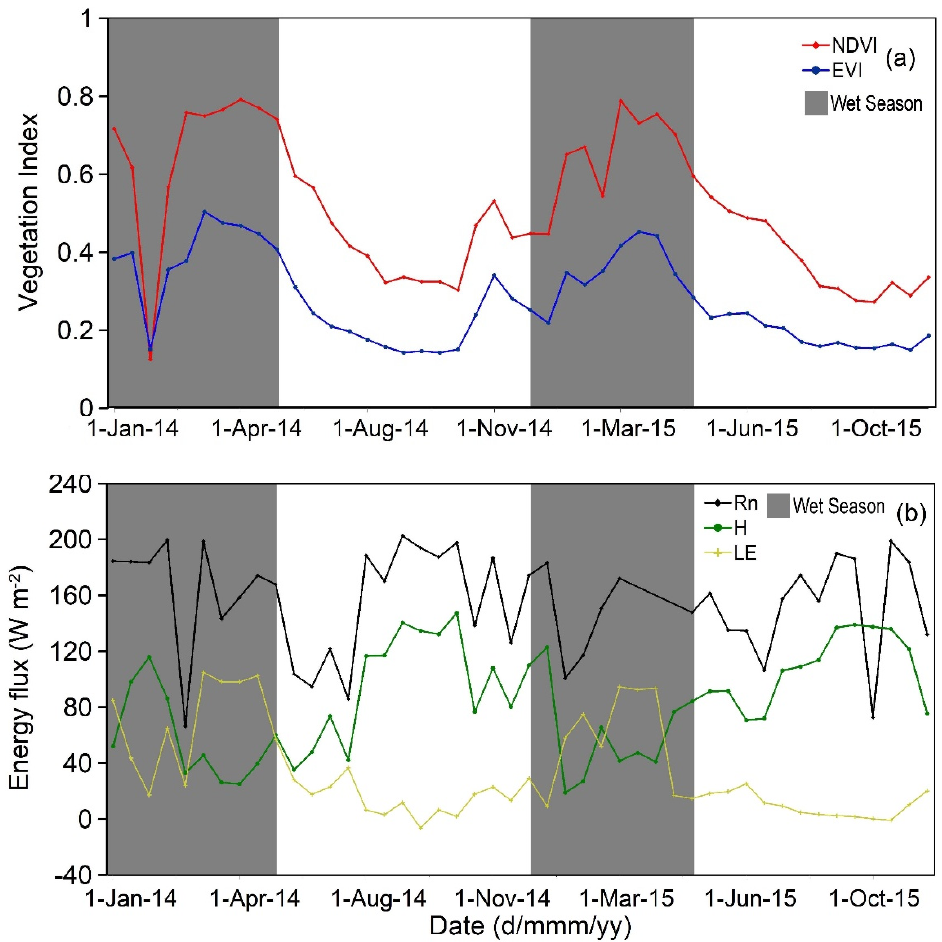
Figure 3. Relationship between: ( a ) vegetation indices (NDVI, EVI); ( b ) energy fluxes measured at the flux tower (daily means corresponding to the exact dates of satellite data). The shaded area indicates the wet season.